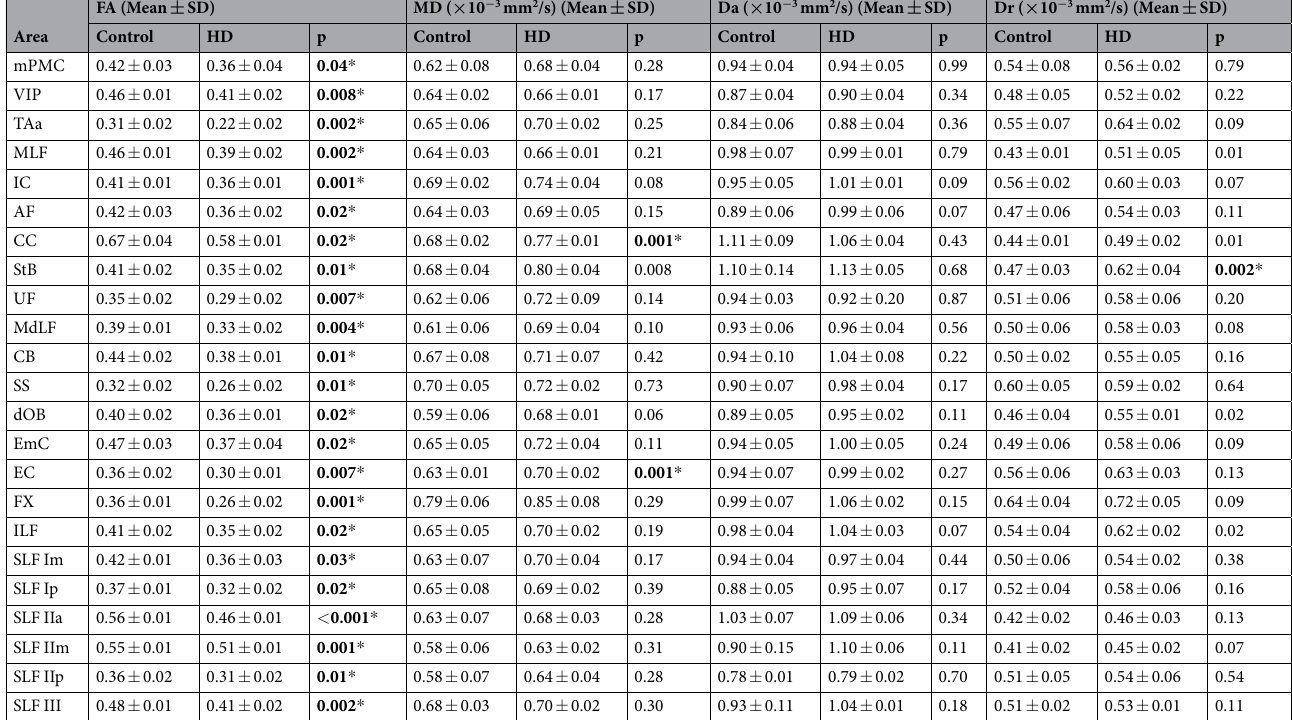
Table 2. Group difference in the minimum/maximum DTI-derived measures based on analysis of the Poisson model and TBSS. These data were tested as significant group difference with independent t-test using FDR correction with q value 0.05 ( * ). SD: standard derivation. FA: fractional anisotropy; MD: mean diffusivity; Da: axial diffusivity; Dr: Radial